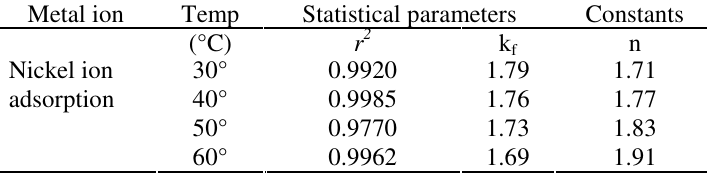
Table 5 . Freundlich isotherm